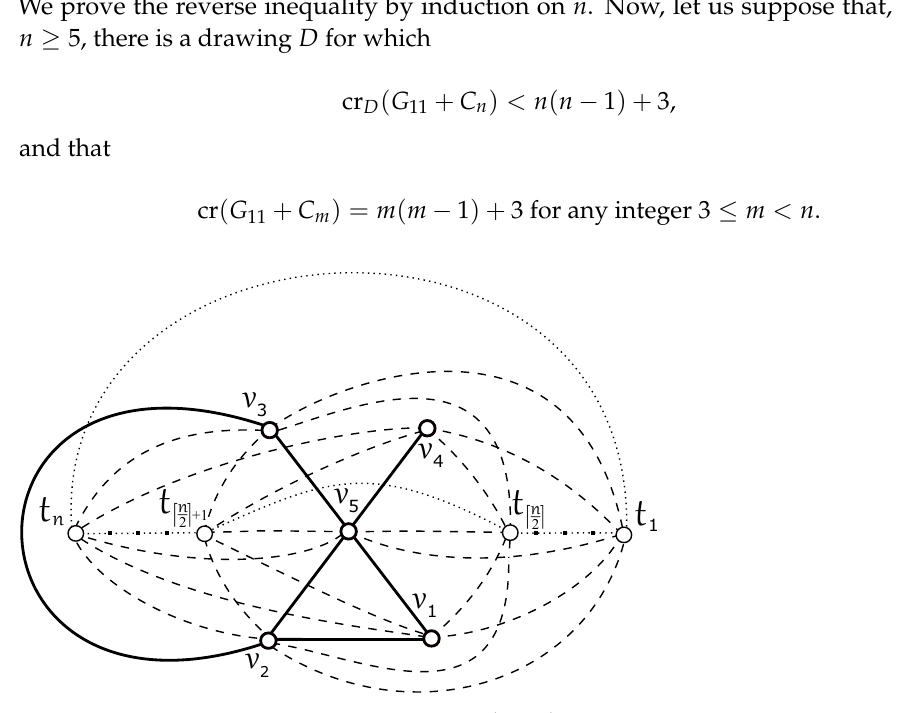
Figure 5. The good drawing of G 11 + C n with n ( n − 1 ) + 3